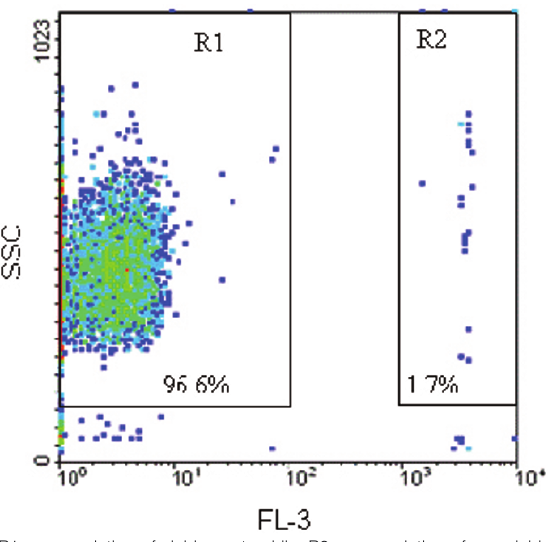
Figure 1. A representative density plot of neurophil population, isolated from peripheral